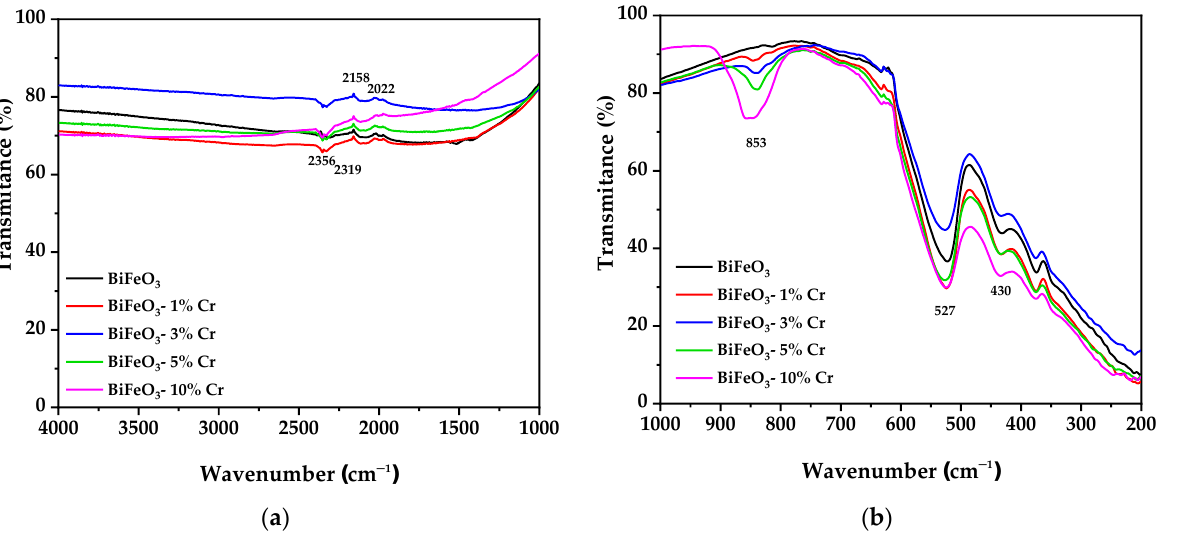
Figure 4. FTIR spectra of pure and Cr-doped BiFeO 3 int the region (a)4000-1000 cm -1 and (b)100- 200 cm -1.